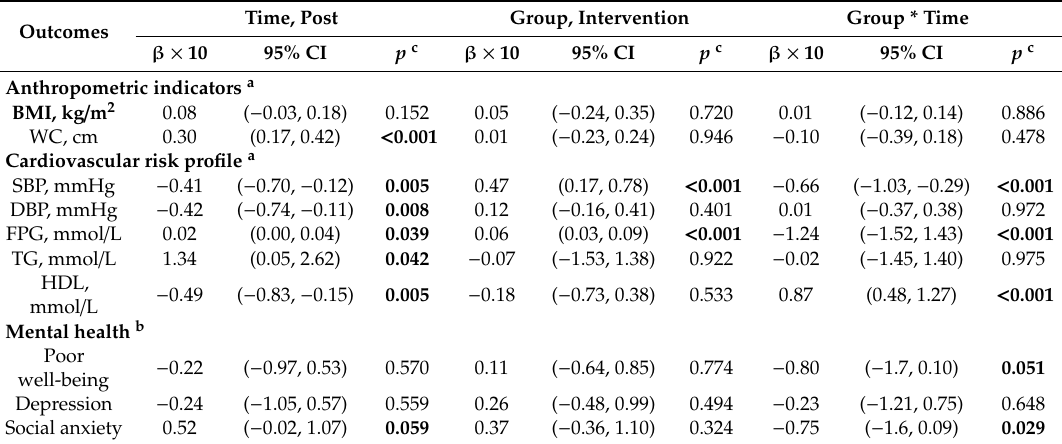
Table 4. Regression analysis of di ff erent outcomes before and after